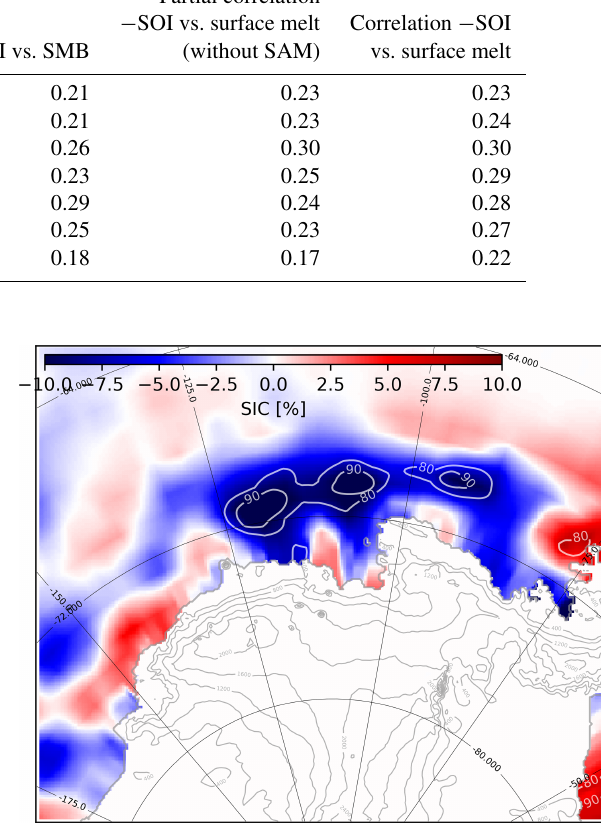
Figure 14. Summer sea ice cover (%) anomaly (composites minus the climatology over 1979–2017) during El Niño events in JJA (6 months before). Contours represent significance with Welch’s t